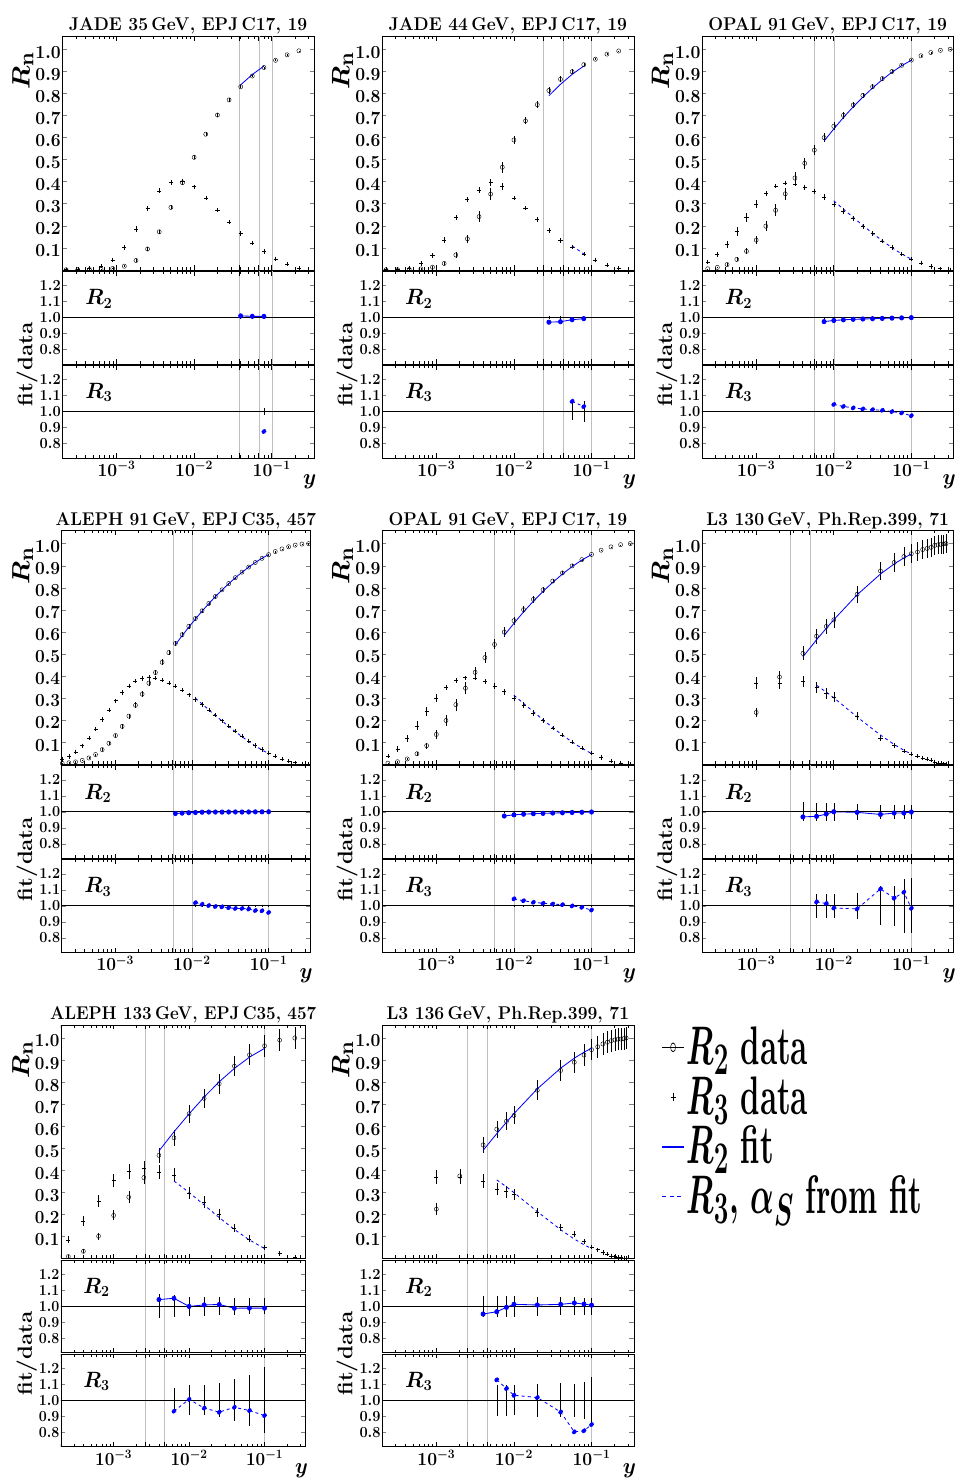
Figure 1 . Comparison of data and perturbative predictions supplemented by hadronization cor- rections in the H L model using for the strong coupling the value obtained from our global (cid:12)t, eq.